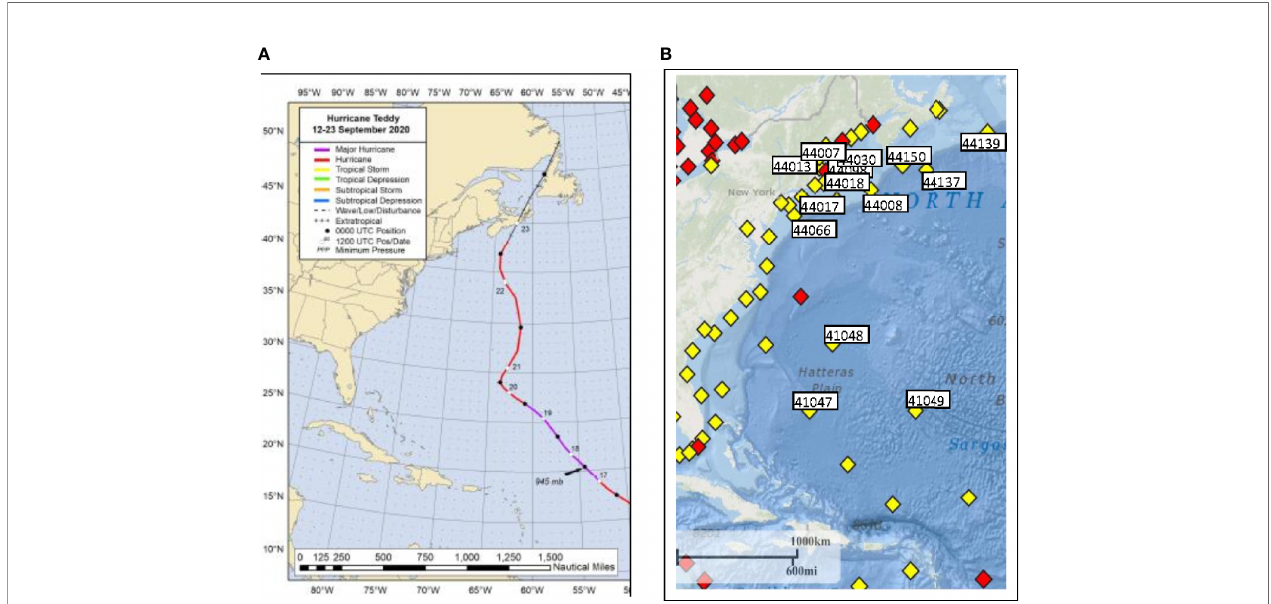
FIGURE 5 | (A) Figure 5 Best track for Hurricane Teddy, 12-23 September 2020. (B) Fourteen NDBC and Canadian buoys used in this